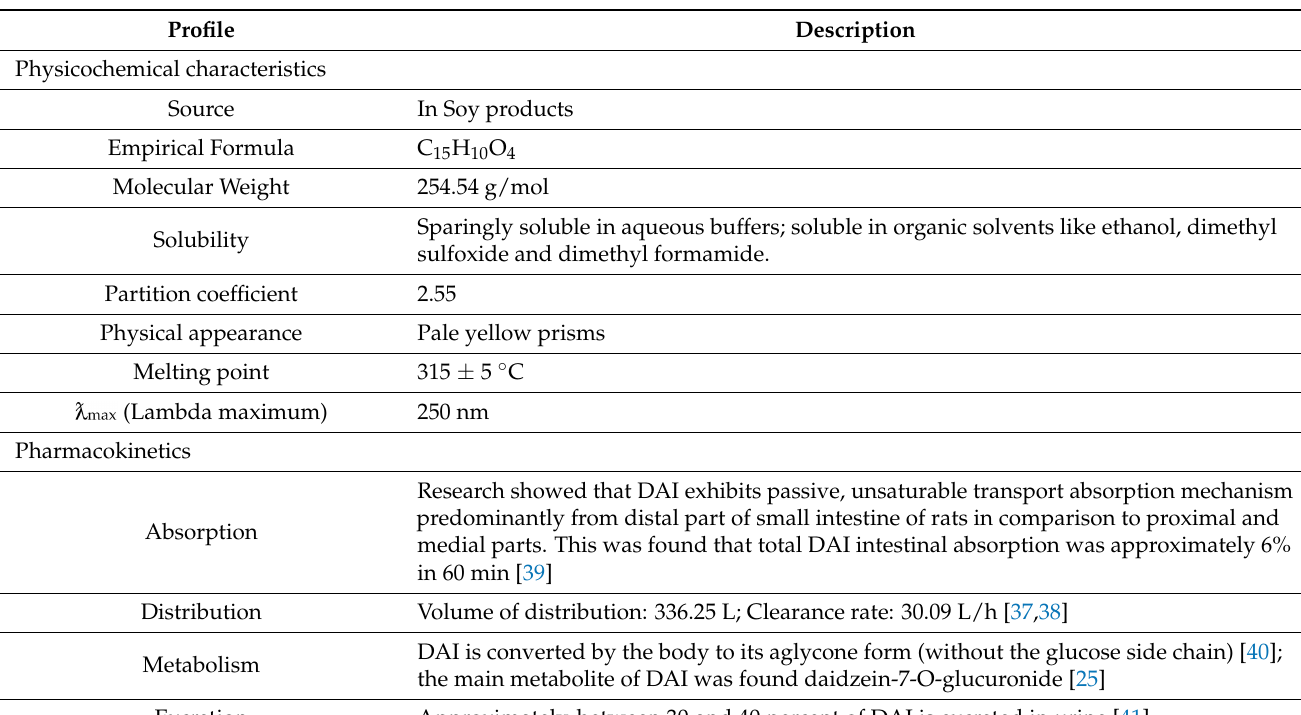
Table 1. Description of physicochemical characteristics and pharmacokinetic profile of Daidzein